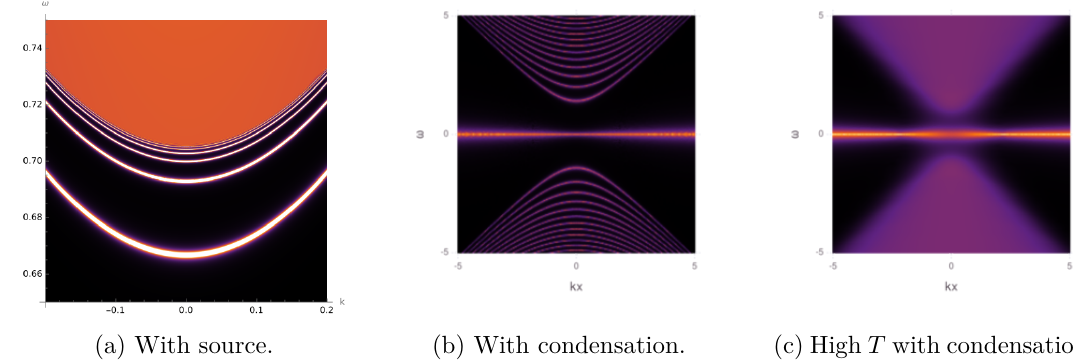
Figure 5 . Tower of poles. The spectral density function in the mixed quantization near k = 0 , ω = 0 . 7 in the case of m = − 1